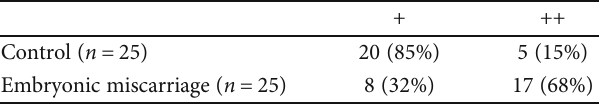
Table 2: Comparison of Lactobacillus concentration in vaginal microbiota. − + ++ +++ ++++ Control ( n = 25 ) 0 (0%) 0 (0%) Lactobacillus concentration was categorized into four levels according to the number of Lactobacilli in each fi eld of view and 5 – 8 fi elds were observed. No Lactobacillus was recorded as (-); less than 1 was recorded as (+); 1 – 5 was recorded as (++); 6 – 30 was recorded as (+++); and more than 30 was recorded as (++++). The metered data is recorded in N (%), p < 0 : 001 . Table 3: Comparison of diversity of the vaginal microbiota. + ++